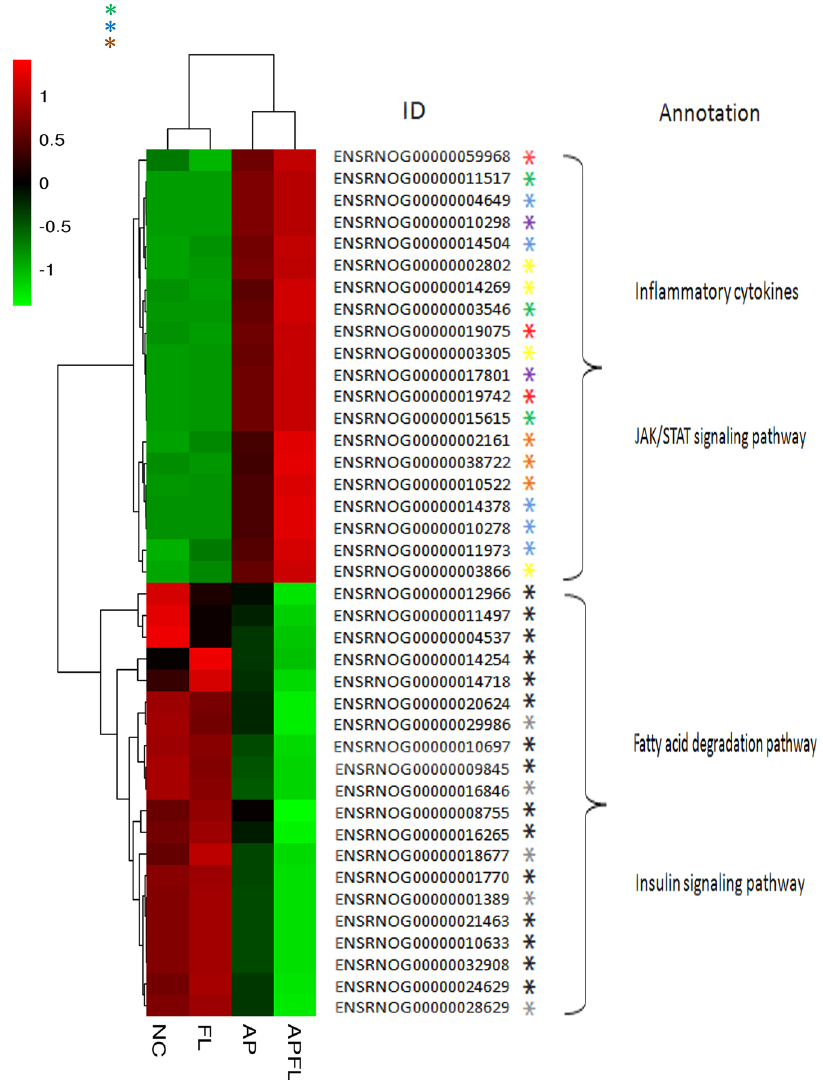
Figure 7. Cluster analysis of DEGs annotated in pathways associated with lipid metabolism and inflammation. The heatmap shows the expression levels of DEGs between APFL group and AP group. Transcript levels of genes encoding components involved in lipid metabolism were marked with an asterisk ( * ), insulin signaling pathway were marked with an asterisk ( ), JAK/STAT signaling pathway were marked with an asterisk ( ), endoplasmic reticulum stress were marked with an asterisk ( ), chemokine receptors were marked with an asterisk ( ), tumor necrosis factor receptor superfamily were marked with an asterisk ( ), interleukin were marked with an asterisk ( ) and toll-like receptors were marked with an asterisk (